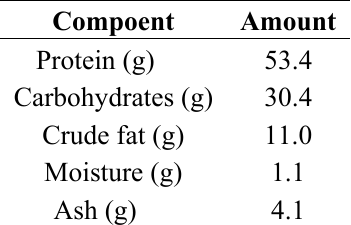
Table 2. Approximate Composition of Freshwater Clam Extract (FCE) per 100